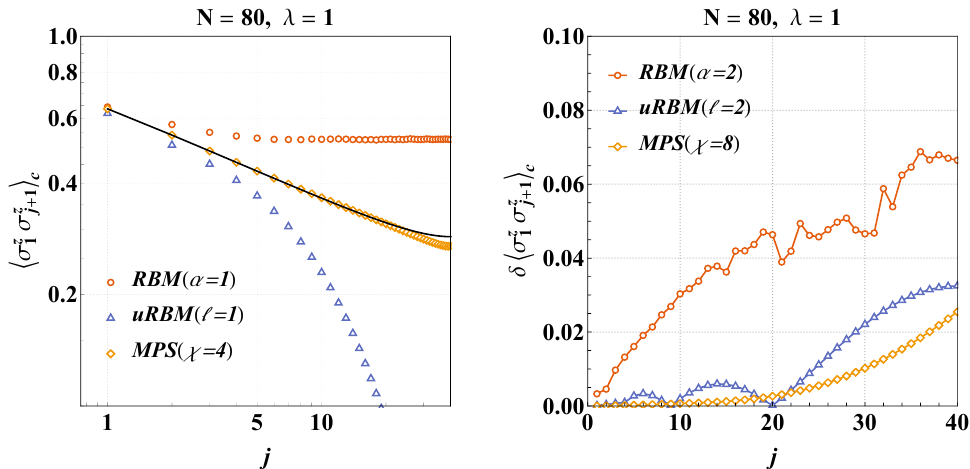
Figure 5: ( left ) Two-point connected correlation function in log-log scale at the critical point for different variational ansatz and smaller description, i.e. α = (cid:96) = 1 and χ = 2 (cid:96) + 1 = 4. Black full line are the exact analytical results. ( right ) Relative error from the exact data when larger NN representations are considered; here we compare RBM / uRBM with α = (cid:96) = 2 with the canonical MPS with χ = 2 (cid:96) + 1 = 8. All the data for RBM has been obtained by using the optimised wave functions in Ref. [ 13 ]